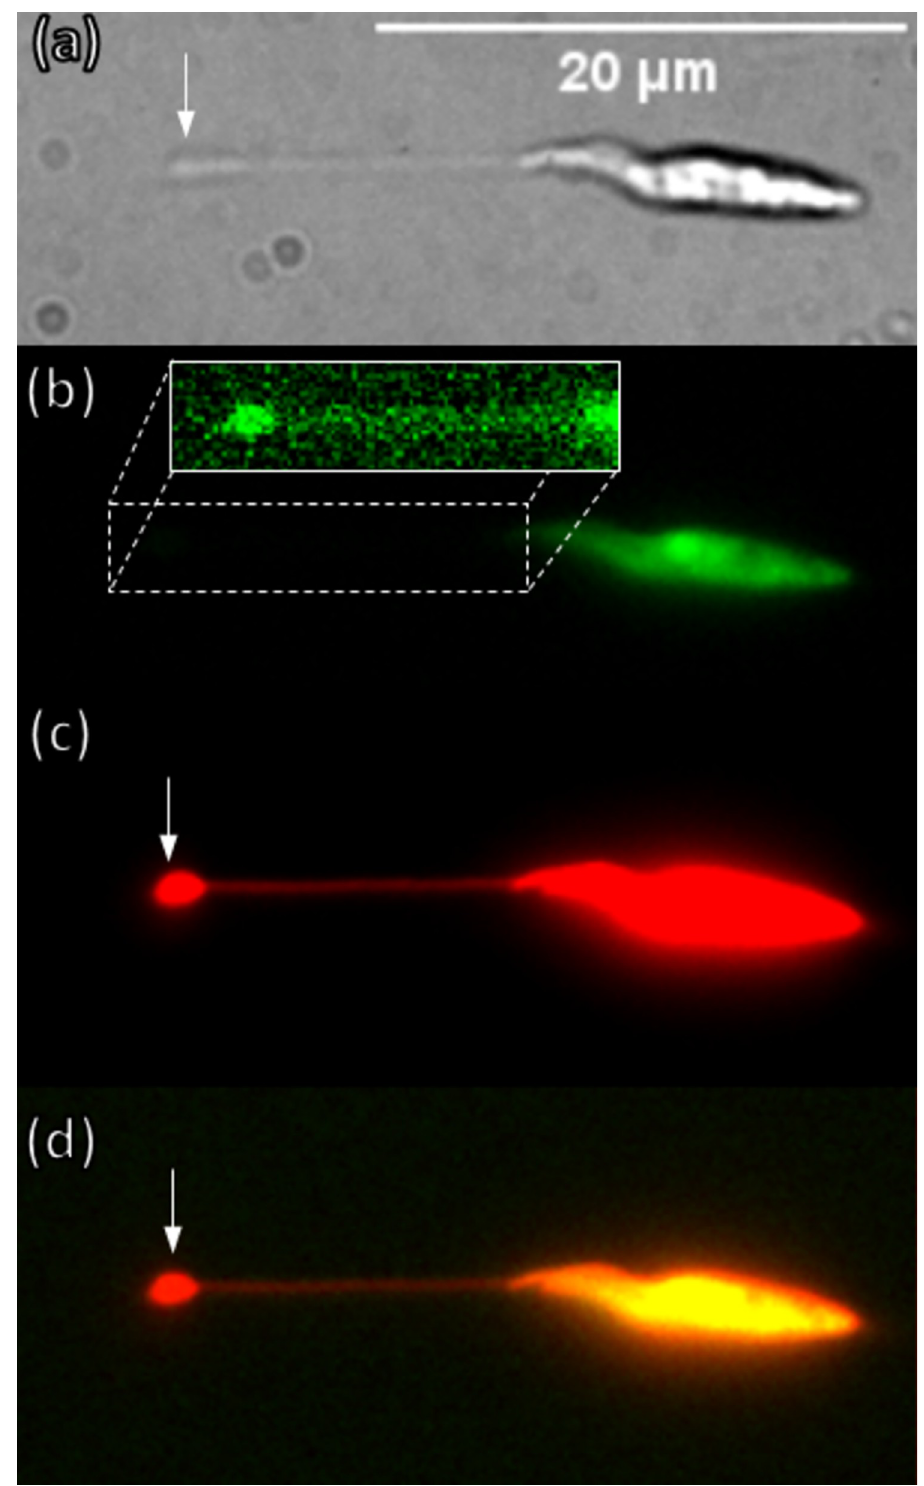
Fig 3. Nanotubules dyed with cytoplasmic (CFSE) and membrane (R18) dyes. (a) bright field image of an epimastigote at 90x, after it was extended by shear stress. The anchoring pad is marked by a white arrow at the end of the nanotubule. (b) CFSE fluorescence is mainly at the soma of the parasite, but a faint signal can be seen at both the anchoring pad and the nanotubule (see inset where brightness was increased for visibility) (c) R18 fluorescence levels,